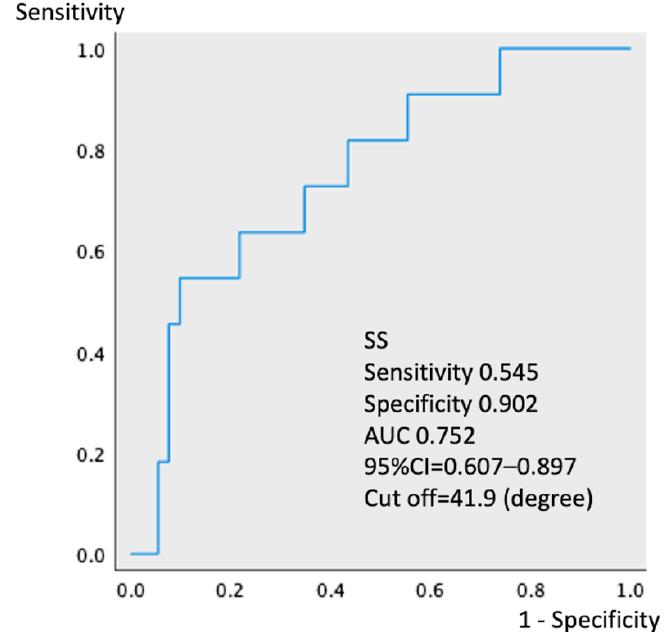
Figure 3. Receiver operating characteristic analysis showing that the cutoff value for sacral slope is 31.9° (95% confidence interval 0.607 – 0.897, p = 0.001, AUC 0.752). The sensitivity and specificity are 0.545 and 0.902, respectively. SS, sacral slope; AUC, area under the curve; CI, confidence interval.